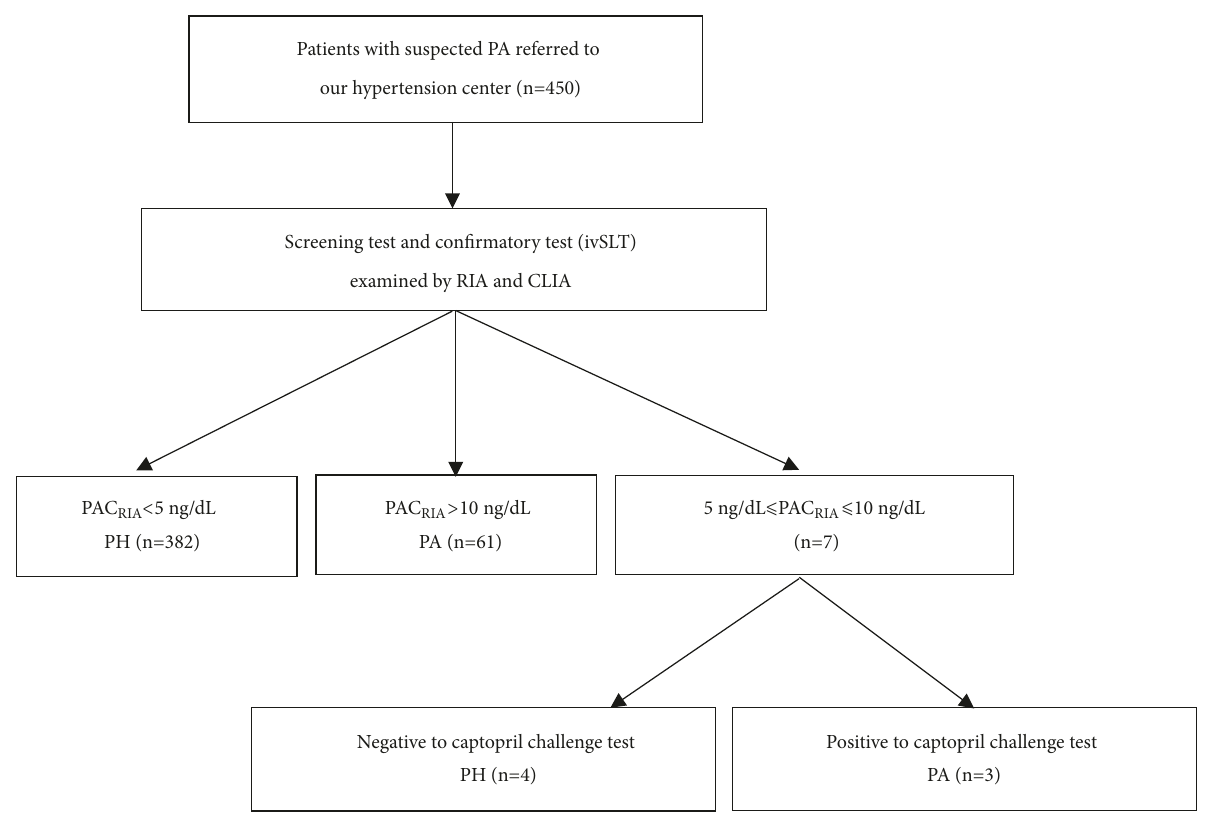
Figure 1: Flowchart of the study. 450 hypertensive patients with suspected PA were enrolled. After screening and confirmatory tests, 386 patients were diagnosed with PH and 64 patients with PA. PH: primary hypertension; PA: primary aldosteronism; RIA: radioimmunoassay; CLIA: chemiluminescent immunoassay; PAC RIA : plasma aldosterone concentration measured by radioimmunoassay; ivSLT: intravenous saline loading